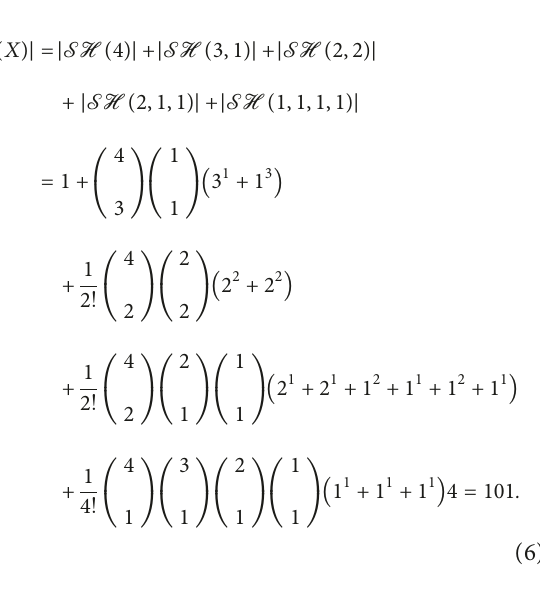
, φ , φ 􏼈 􏼉 3 􏽮 􏽯 ) i i � 1 1 , 3 2 , 3